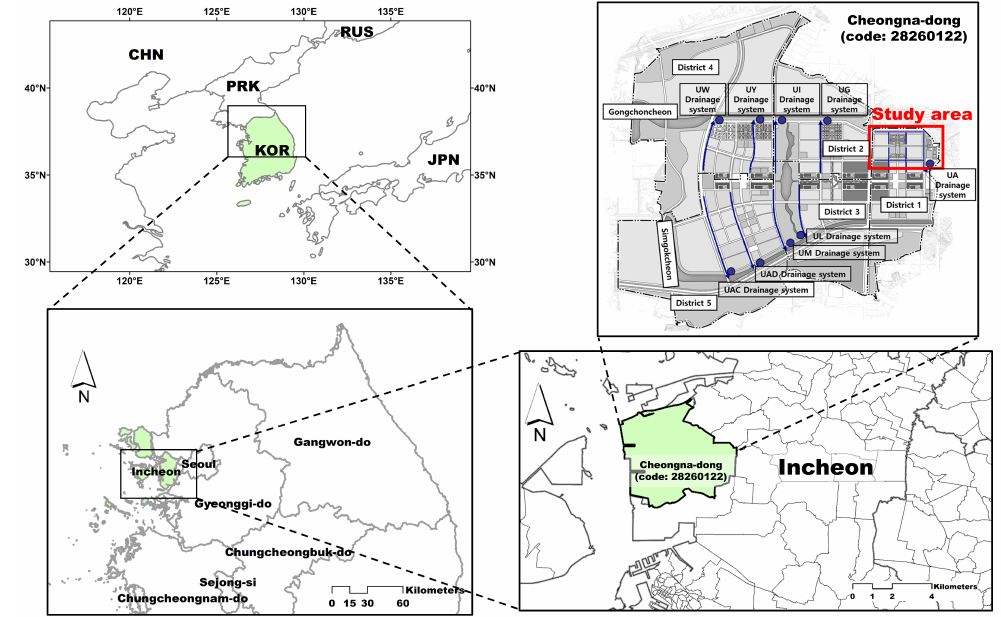
Figure 1. The location of the study area in Cheongna-dong, Incheon, South